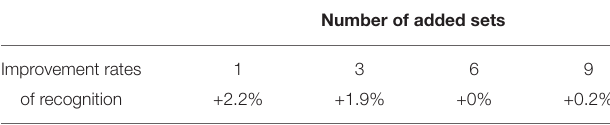
TABLE 2 | Contribution of the number of sets from the new user in improving recognition accuracy.